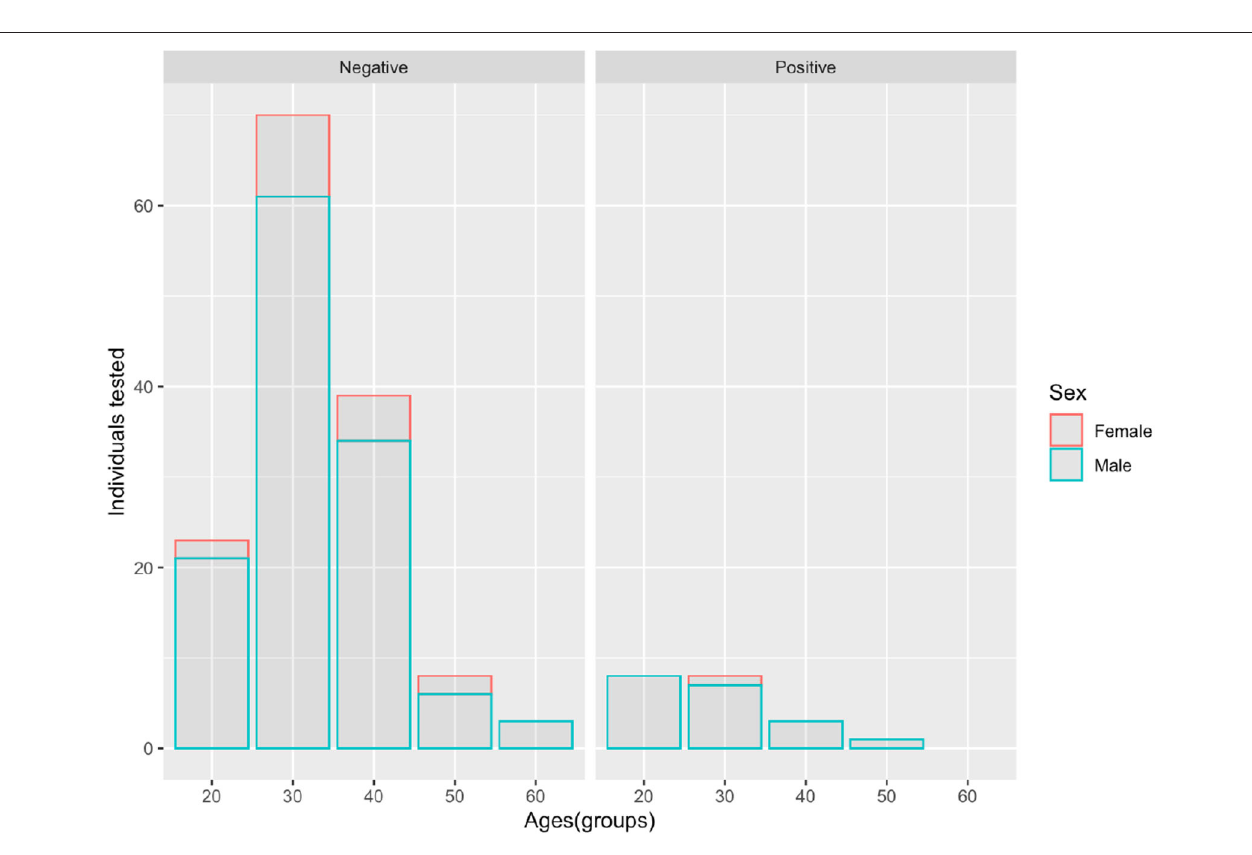
FIGURE 3 | Age and sex distribution for SARS-CoV-2 RT-qPCR positive tests among the 163 special forces police officers included in the study (Viral load is expressed as log 10